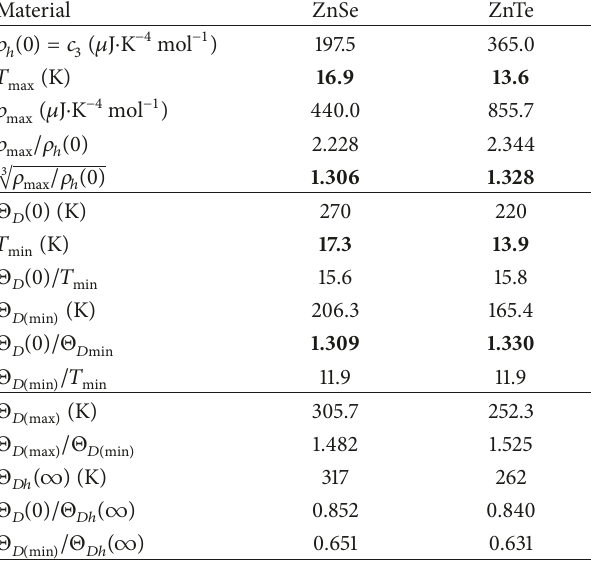
Table 4: Pieces of evidence of the close correlation between the characteristic cryogenic non-Debye features of the 𝜌 𝑝/ℎ (𝑇) ≡ 𝐶 (𝑇)/𝑇 3 curves (see the insets of Figures 2 and 3) and the 𝑝/𝑉ℎ respective Debye temperature curves, Θ 𝐷 (𝑇) (see Figures 4 and 5). The prominent features of the 𝜌 𝑝/ℎ (𝑇) curves are characterized by the 𝑇 → 0 levels for the lattice heat capacity, 𝜌 ℎ (0) = 𝑐 3 , the ≡ 𝜌(𝑇 ) , and the coordinates of their maxima , 𝑇 and 𝜌 max max max /𝜌 (0) > 1. The Θ (𝑇) curves are respective elevation ratios, 𝜌 ℎ 𝐷(ℎ) max characterized above all by the limiting ( 𝑇 → 0 ) levels, Θ 𝐷 (0) , ≡ Θ (𝑇 ) , and the coordinates of their minima , 𝑇 and Θ 𝐷 𝐷 min min min /Θ (0) < 1. The material- the corresponding drop ratios, Θ 𝐷( 𝐷 min ) /𝑇 specific ratios Θ 𝐷( are quoted for comparisons with the min ) min /𝑇 > 14 (cf.Section5)ofcloseapproach generalcondition Θ 𝐷( min ) min to asymptotic behaviour due to (25). Furthermore, the maximum values of the effective Debye temperatures, Θ 𝐷( , the theoretical max ) high-temperature limiting value of the true Debye temperature, Θ (∞) (42), and several characteristic ratios, the approximate 𝐷ℎ equality of which, for both materials, is indicating their high degree of similarity, are quoted. Particularly the large deviations from unity /Θ (0) ≈ 0.76, and of the of the cryogenic drop ratios, Θ 𝐷( 𝐷 min ) /Θ ≈ 1.5, ratios for the subsequent rise to maxima, Θ 𝐷( 𝐷( min ) max ) illustrate the considerable strength of 𝑇 -related variations of Debye temperatures for both materials under